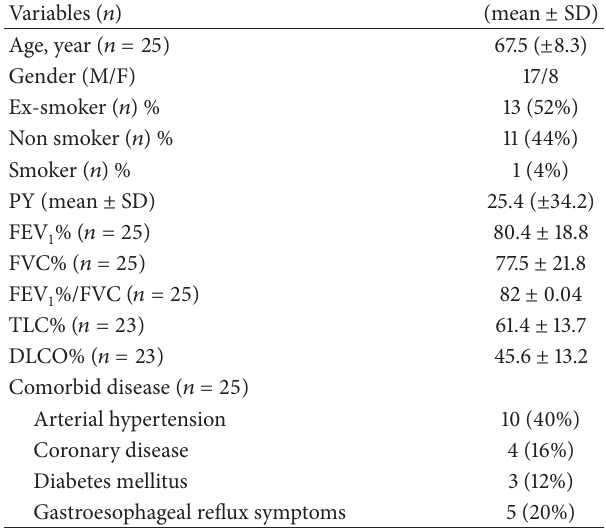
Table 1: Demographic and clinical data of the study population.